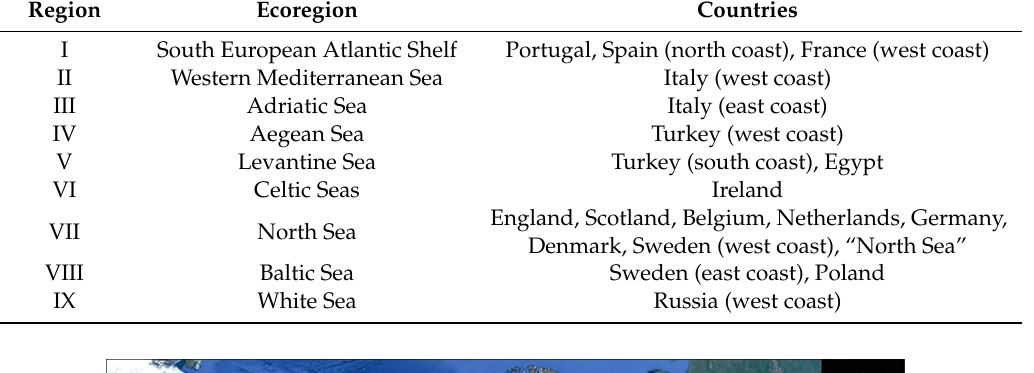
Table 2. Regions included in the European biofouling database.